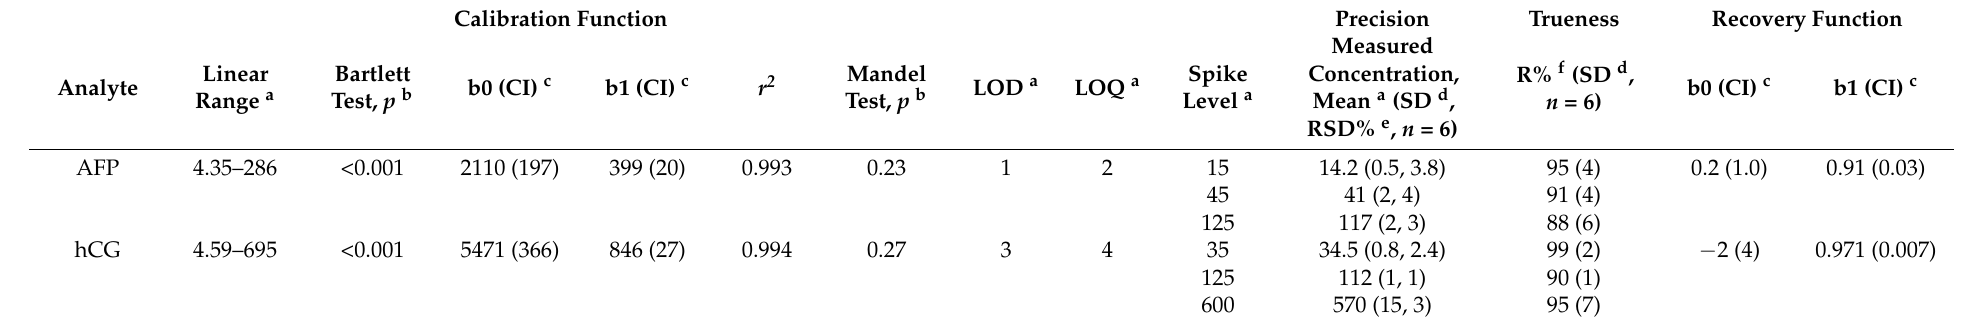
Table 1. Linearity of the weighted calibration functions, limit of detection (LOD), limit of quantitation (LOQ), repeatability (intra-day precision) and trueness of analysis of alpha-fetoprotein (AFP) human chorionic gonadotropin (hCG) in cerebrospinal fluid. The weighting factor 1/X was chosen between two weighting factors, i.e.,: 1/X and1/X2, based on the variance and Mandel test for both AFP and hCG. Accuracy was evaluated under repeatability conditions from analysis of spiked blank CSF. The expected spike concentrations and the corresponding recovery values are shown for three representative spike levels (low, medium, and high concentration level) of the six spikes that were analysed to calculate the recovery